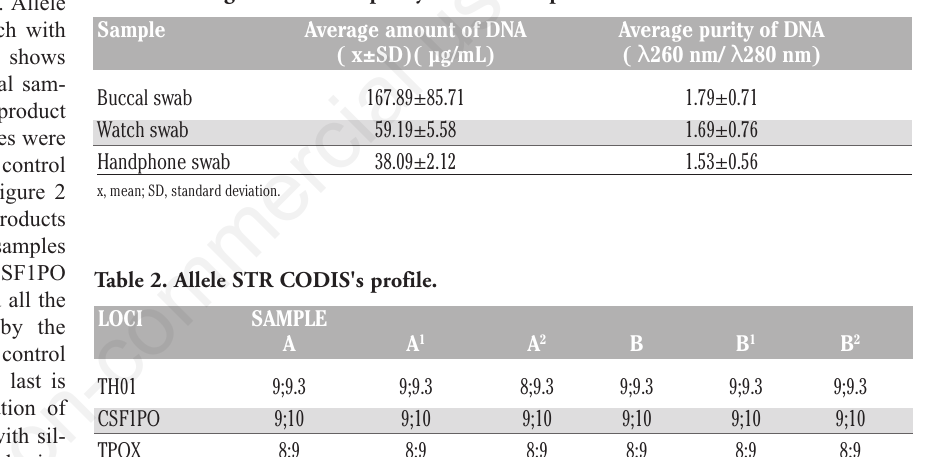
Table 1. Average amount and purity of DNA samples.